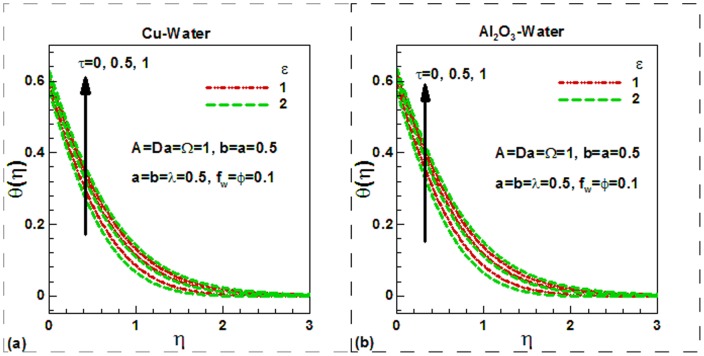
Effects of dimensionless time and scaling parameters on dimensionless temperature for (a) Cu-water and (b) Al2O3-water nanoflu.